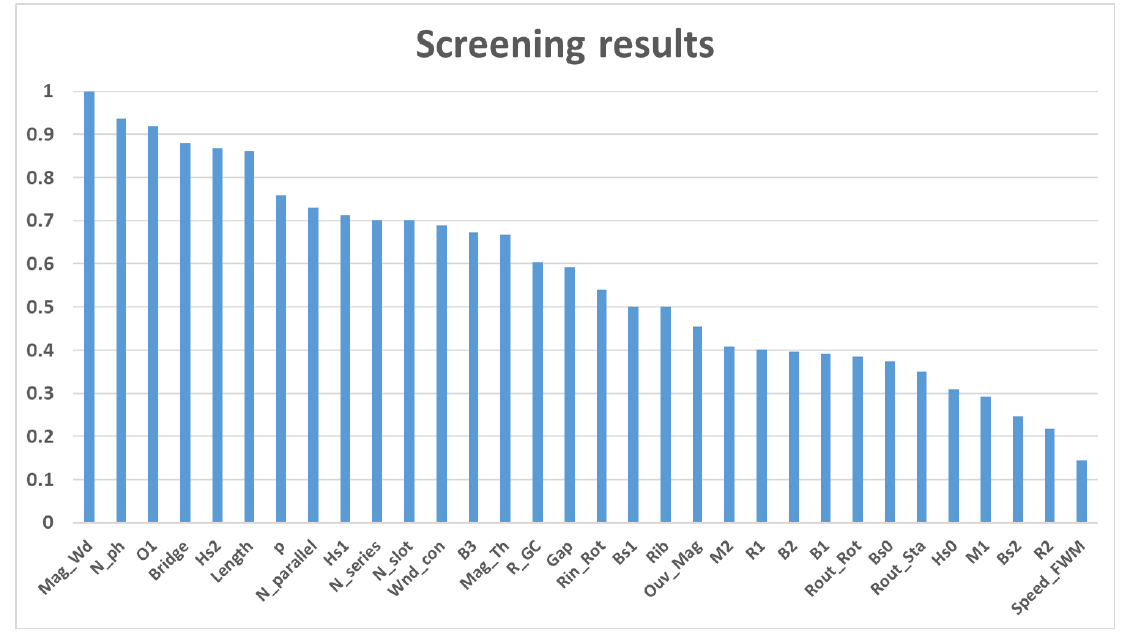
Figure 13. Normalized global impact of the design parameters deduced from conducted screening